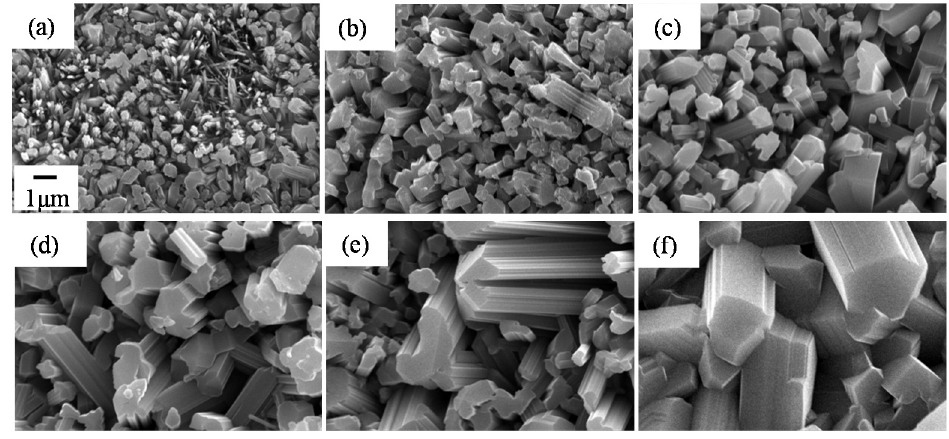
Figure 32. SEM images of surfaces of M10-973 K- y h samples. ( a ) Ti coatings before oxidation, and after oxidation time for ( b ) 3 h, ( c ) 10 h, ( d ) 30 h and ( e ) 50 h.